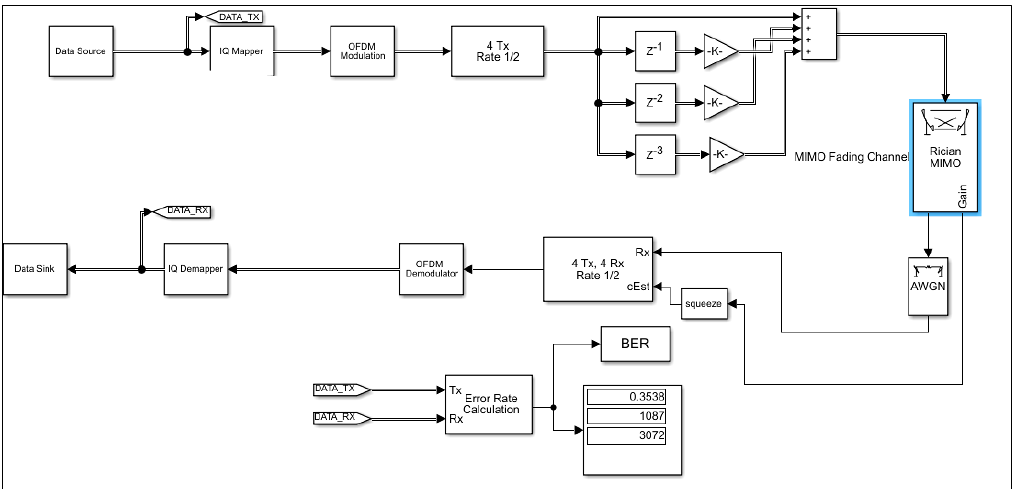
Figure 12. 4×4 LMS-MIMO-OFDM Model in Rayleigh